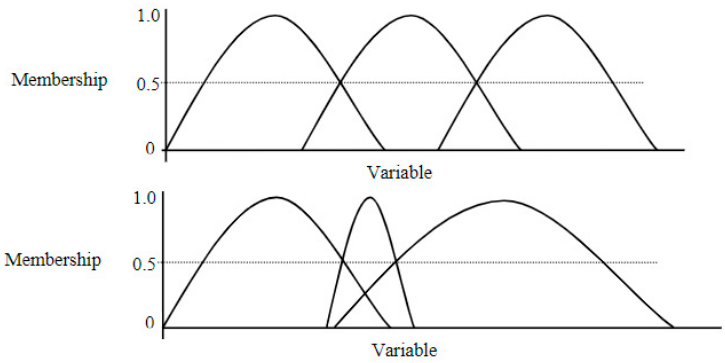
Figure 7. Example of uniform (upper plot) and non-uniform (lower plot) membership functions distribution.